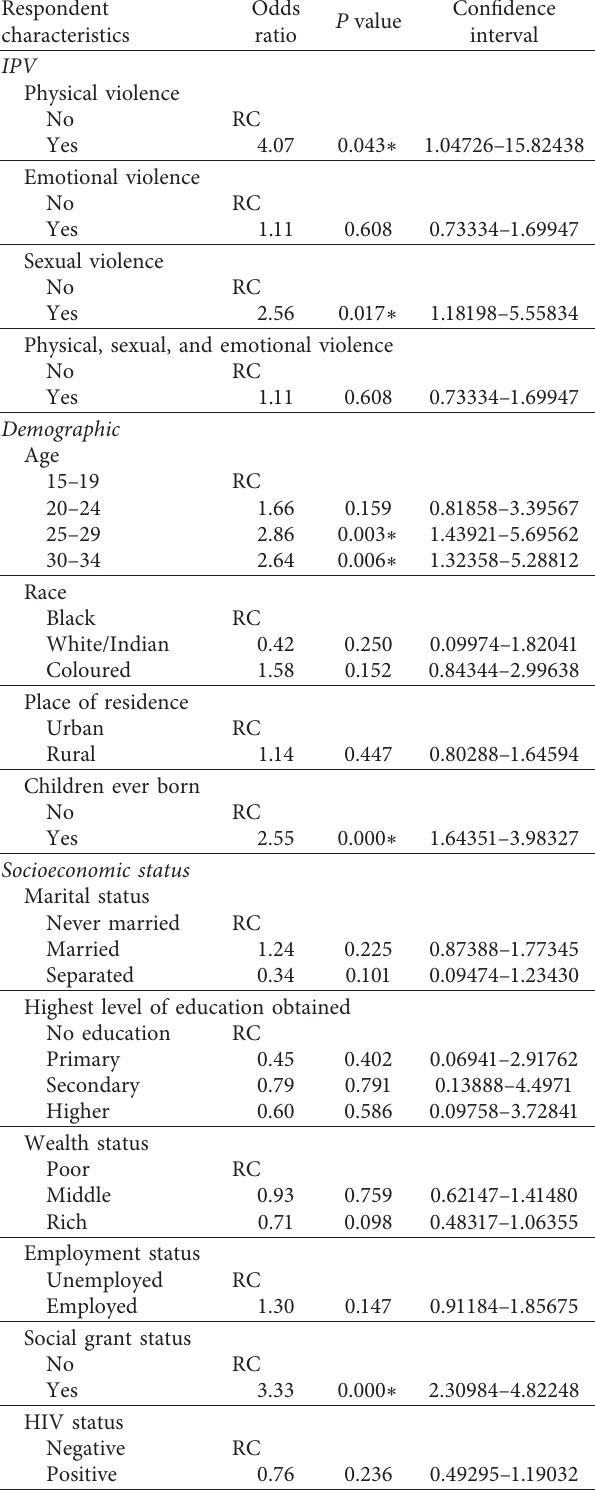
Table 2: Unadjusted logistic regression of the odds of hypertension by characteristics of the